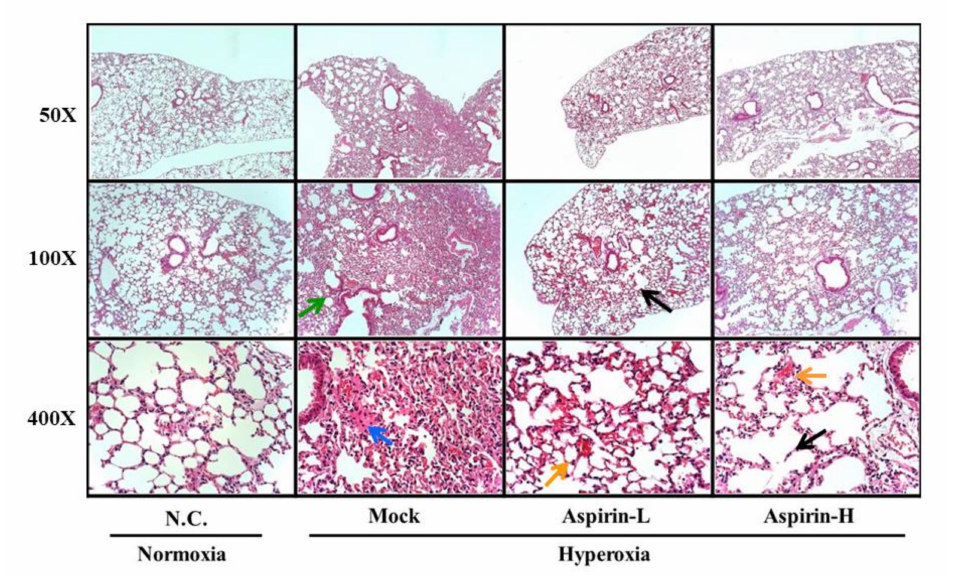
Figure 5. Histopathological analyses of lung tissues in the normal control (NC), mock, aspirin-L and aspirin-H groups. Low magnification (50 × ) images of lung tissues are shown in the upper panel. Medium magnification (100 × ) images of lung tissues are shown in the upper panel. High magnification (400 × ) images are shown in the lower panel. Green: neutrophil aggregation; blue: pulmonary edema; orange: erythrocyte aggregation; black: alveolar